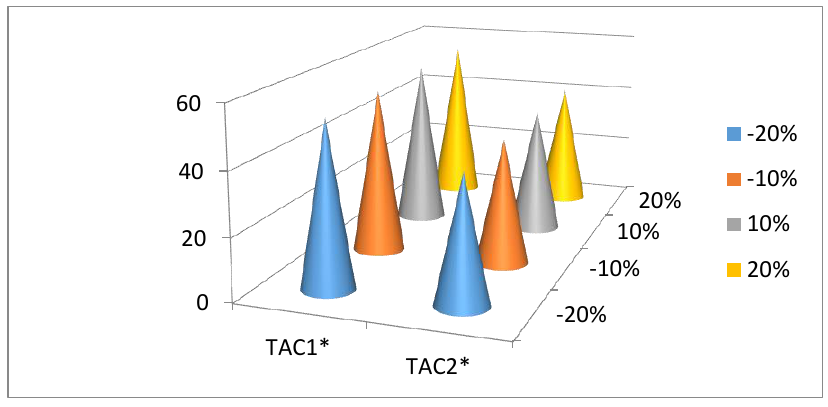
Fig. 8. Minimizing cost of 1 st and 2 nd items for different values of 𝛕 𝟏 , 𝛕 𝟐